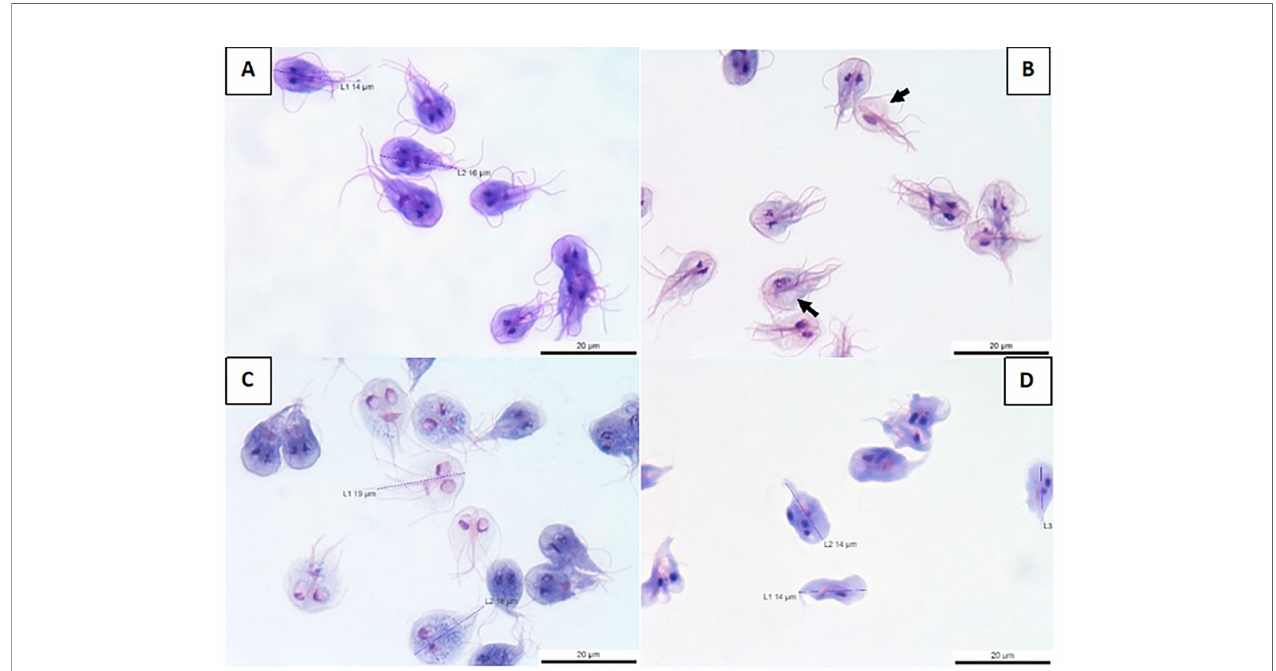
FIGURE 1 | Morphological effects of benzopyrrolizidines on G. lamblia trophozoites. (A) Control cell sample; (B) cells treated with EHV-110-174; (C) metronidazole- treated trophozoites; (D) albendazole-treated trophozoites. The images have 100X. The arrows show those trophozoites that lost a